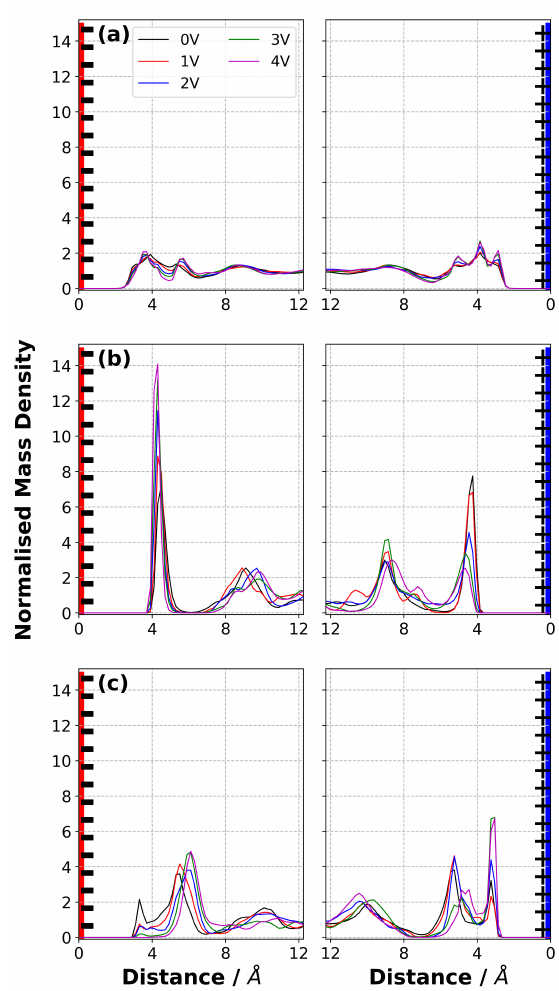
Figure 7. Average normalised mass density distribution of ( a ) [N 4,1,1,1 ][NTf 2 ], ( b ) [N 4,1,1,1 ] + and ( c ) [NTf 2 ] − at 294 K at various ∆Ψ . The first and second columns represent the EDL in the vicinity of negative electrode and positive electrode,